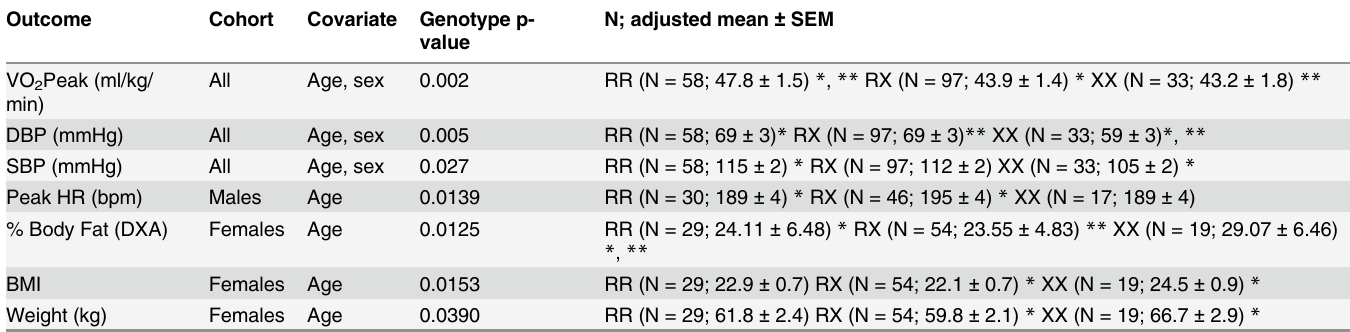
Table 3. Significant associations between all ACTN3 genotypes.